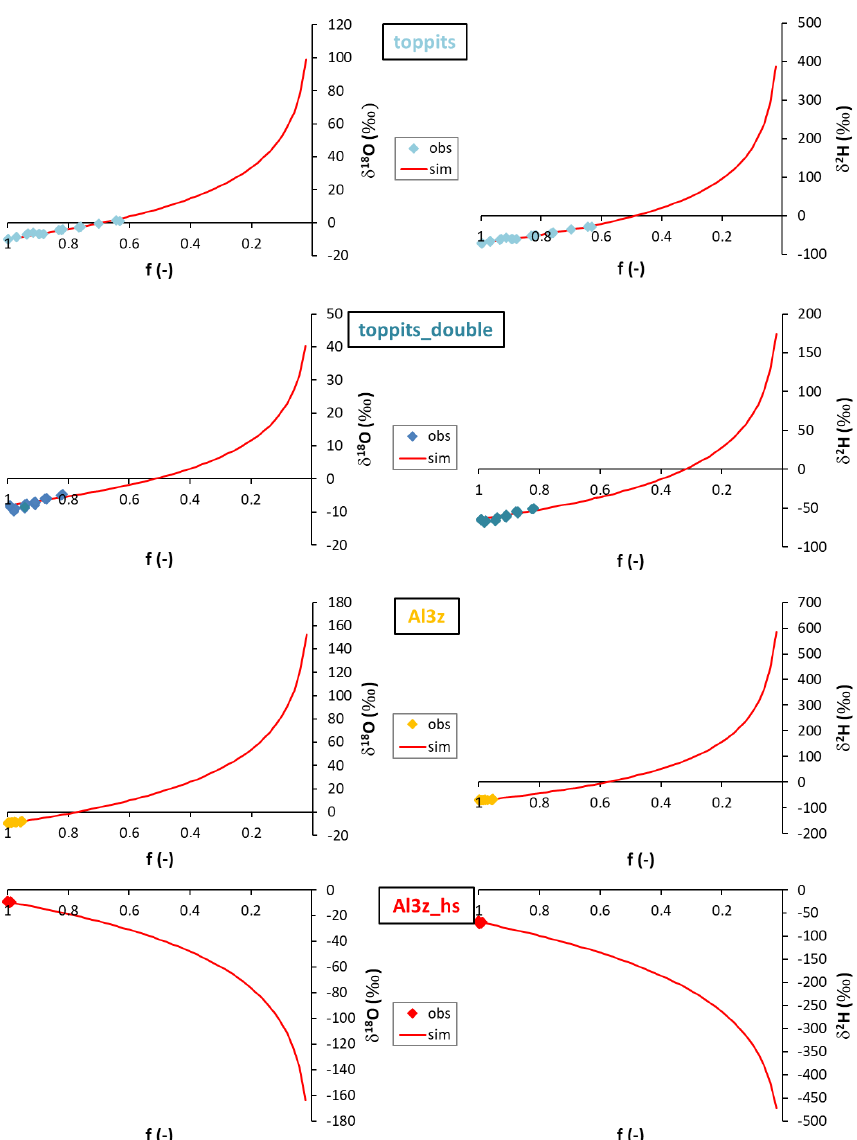
Figure 5. Observations (diamonds; “obs”) and Rayleigh-type simulations (red lines; “sim”) of liquid water δ 18 O (left column) and δ 2 H data (right column) obtained from single- (top row) and double-layer (second row) Toppits® freezer bags and zip-closed-only (third row) and additionally heat-sealed (bottom row) Al-laminated bags as functions of the respective residual water fractions f